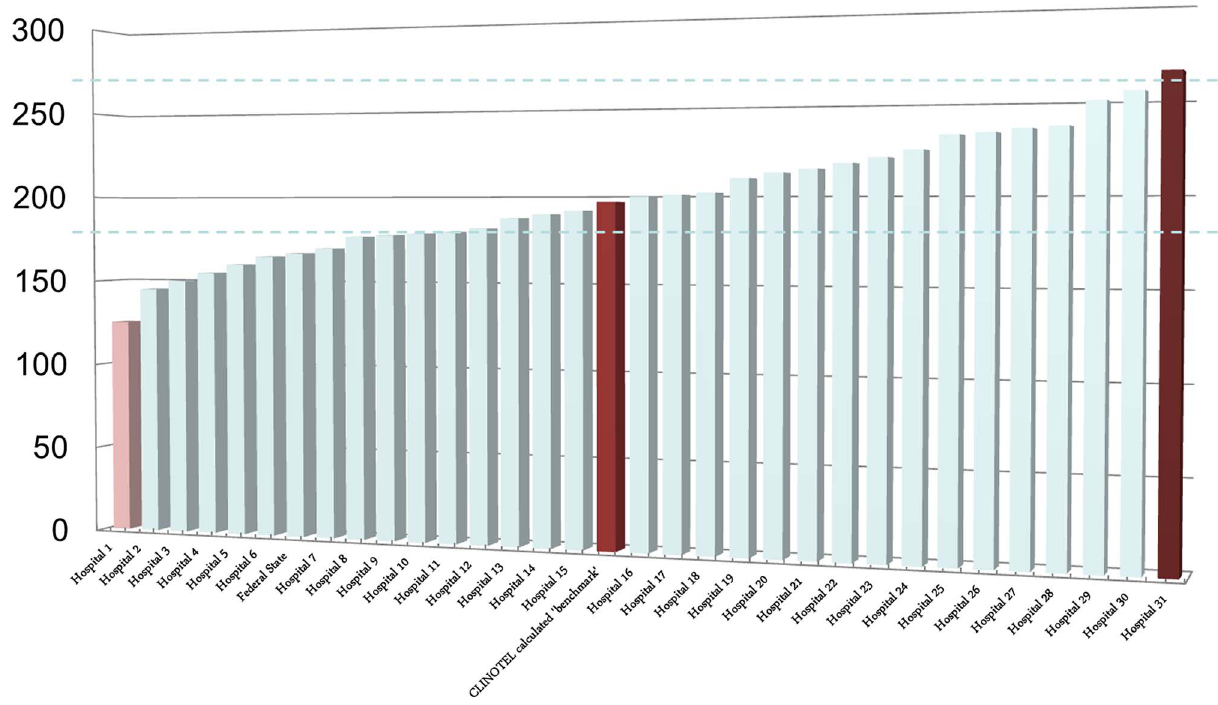
Figure 3. The CLINOTEL “ benchmark ” is the calculated effective cost weight (CW) (German: effektive Bewertungsrelation, BRW ). The highlighted points are representative for various hospitals in different Federal states in Germany by CLINOTEL [33]. Due not to declare which hospital may be less cost effective, the names of the hospitals were